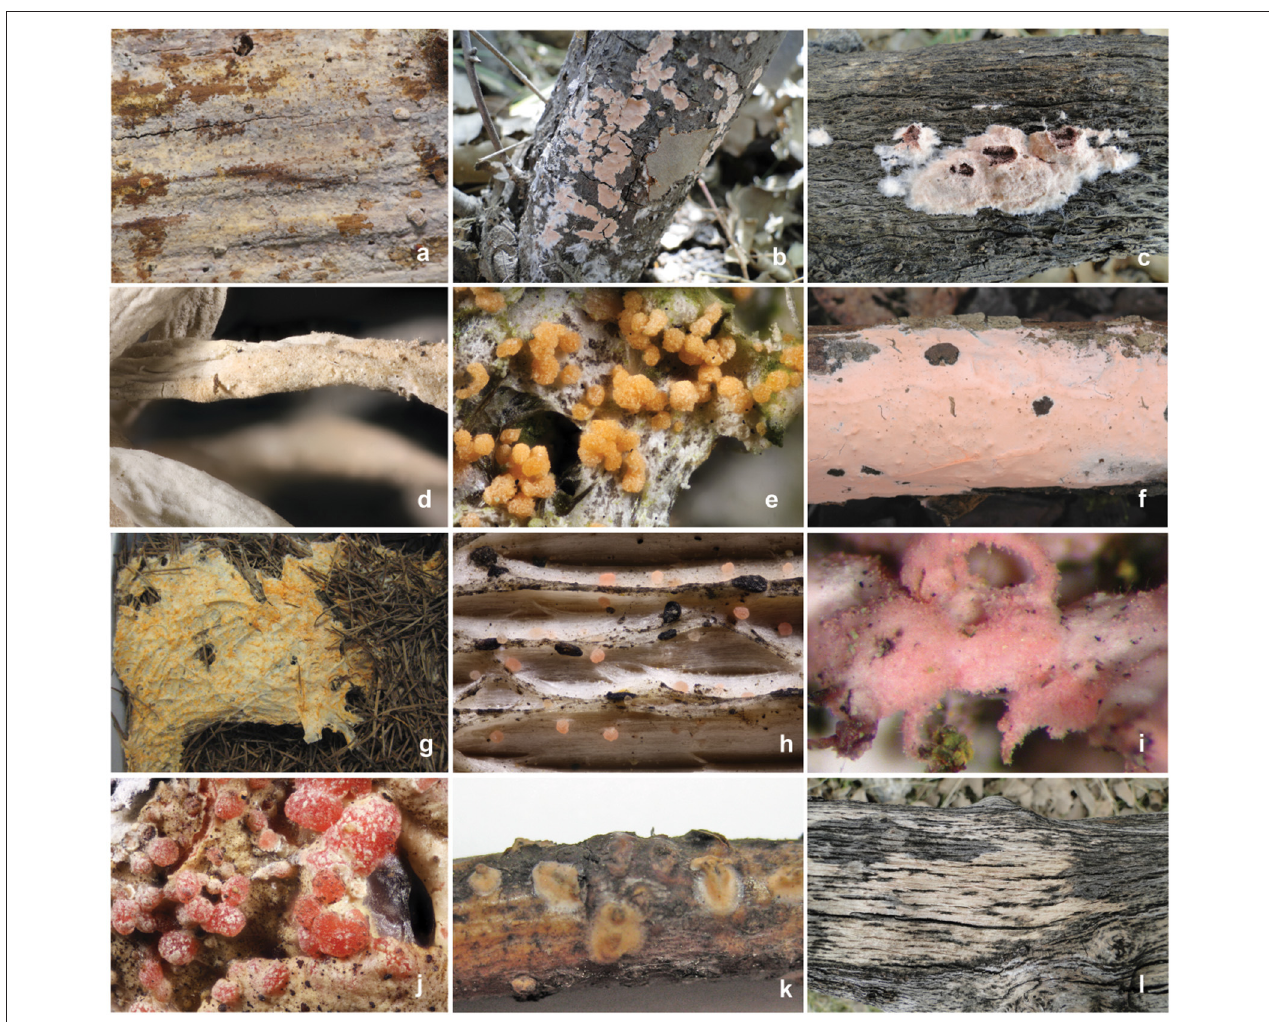
FIGURE 1 | Morphological diversity in Corticiaceae s.s. (a) Mycobernardia incrustans (M. Wilhelm 61060); (b) Corticium meridioroseum (Ghobad-Nejhad 4005); (c) Corticium roseum , asexual form (syn. C. erikssonii ) (Ghobad-Nejhad 3237); (d) Corticium silviae Holotype; (e) Erythricium aurantiacum bulbils (Diederich 17722); (f) Erythricium hypnophilum (Meyer s.n.); (g) Erythricium laetum (E. Camppo s.n.); (h) Laetisaria buckii on wood (Buck 64594); (i) Laetisaria lichenicola on Physcia tenella (Heklau s.n.); (j) Marchandiomyces corallinus on Xanthoparmelia (Heklau s.n.); (k) Marchandiomyces aurantioroseus (F119140, S); (l) Marchandiomyces sp. on wood (Ghobad-Nejhad s.n.). Photos (a,f) by A. Bernicchia; (b,c,g,k,l) : by M. Ghobad-Nejhad; (d,e,h–j) by P.